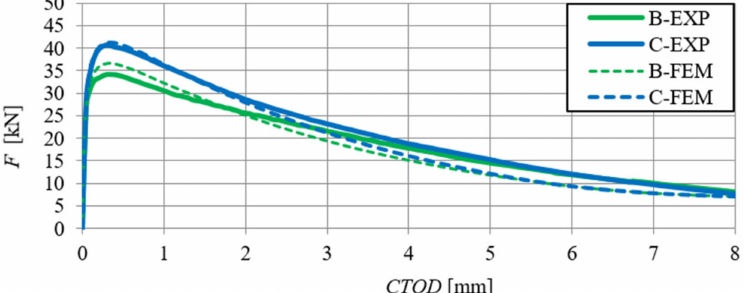
Figure20. Comparisonofnumericalandexperimentalforce-cracktipopeningdisplacementrelationship of SFRHSC beams in three-point bending tests (B and C